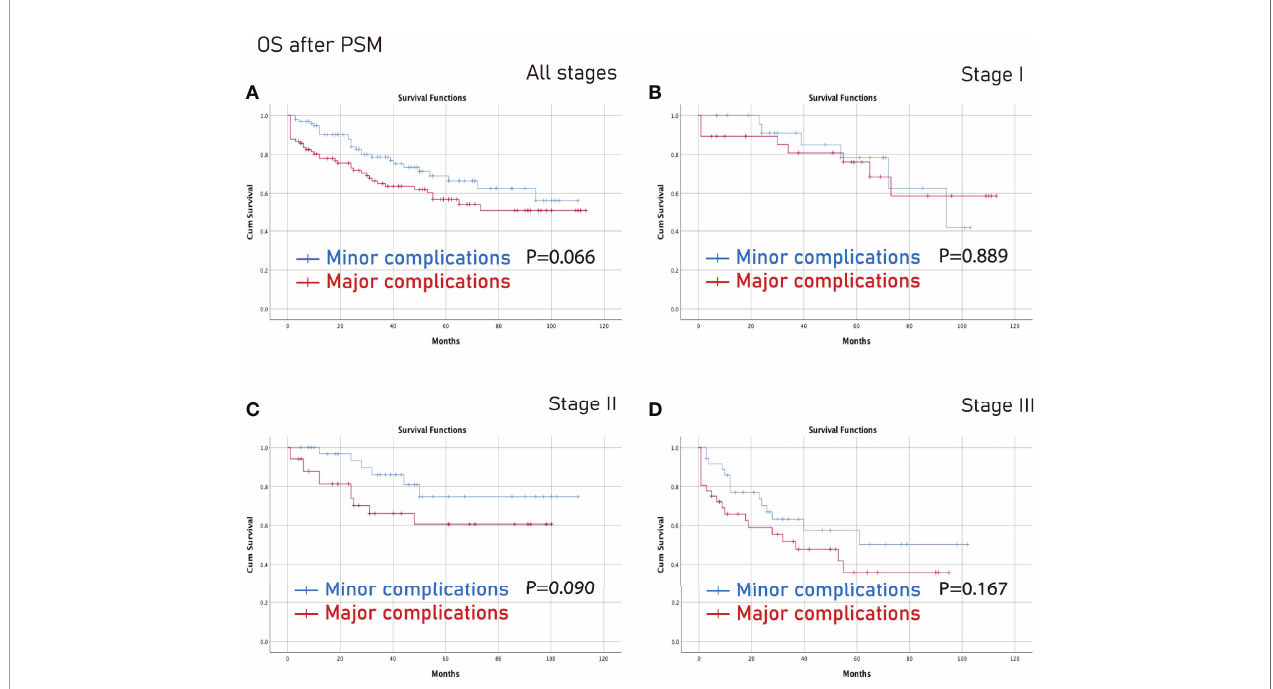
FIGURE 5 | OS between the major complications group and the minor complications group after PSM. (A) , all stages; (B) , stage I; (C) , stage II; (D) , stage III. OS, overall survival; PSM, propensity score matching.